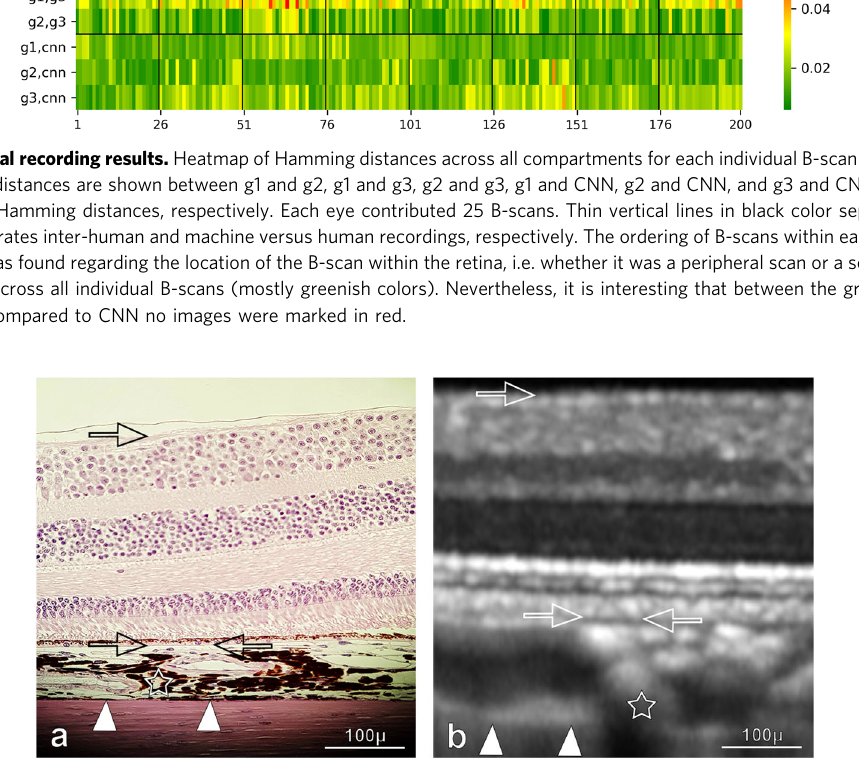
Fig. 6 Multimodal imaging of retinochoroidal zones in a healthy cynomolgus monkey ’ s eye. a A high-resolution histological hematoxylin and eosin staining of a paraf fi n-embedded cross-section of a normal cynomolgus monkey ’ s eye. b Corresponding OCT B-scan from another cynomolgus monkey ’ s eye. Illustrated in both images are the vitreous-retina border (ILM, single arrow), internal part of choriocapillaris (CCi, double arrows), and choroid – sclera interface (CSI, arrow